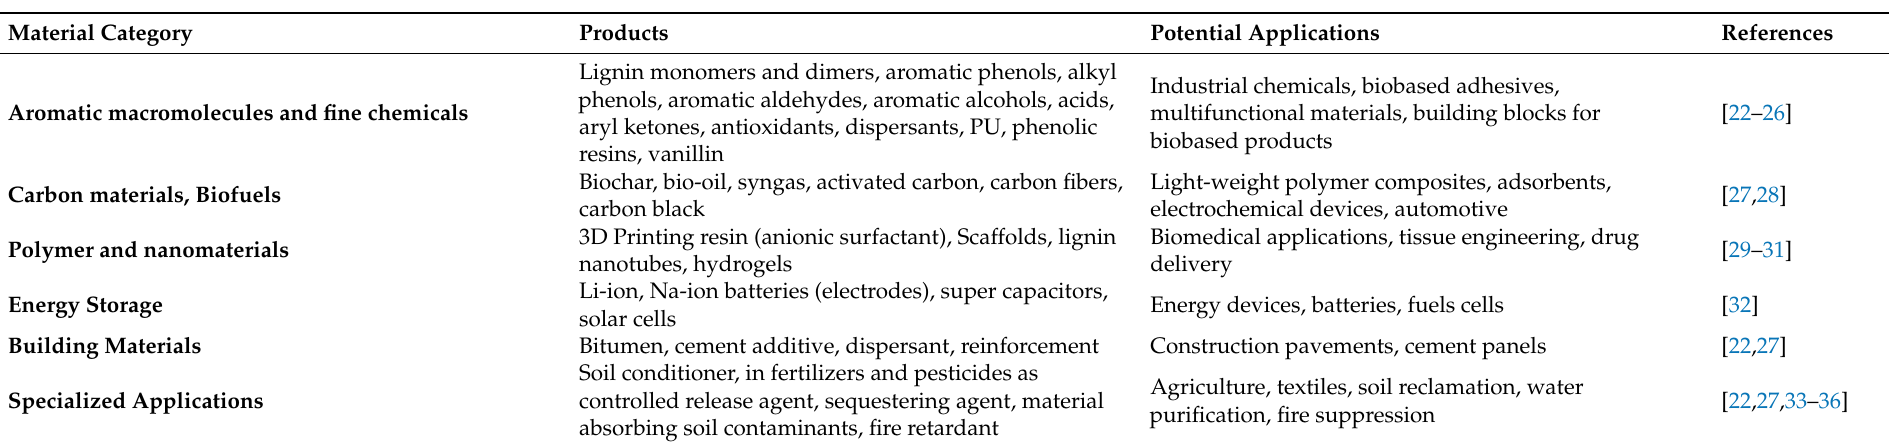
Table 2. List of major Kraft lignin-derived materials categories, functional products and their potential